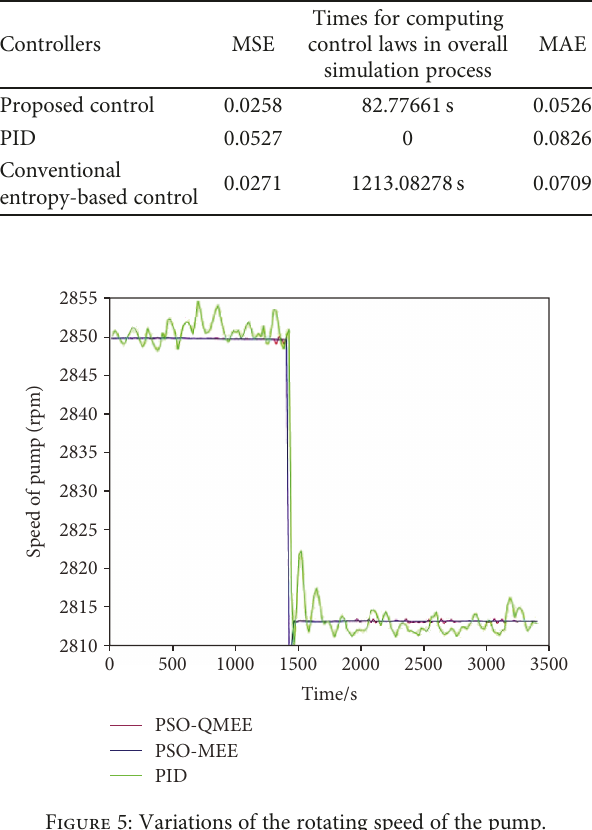
Figure 5: Variations of the rotating speed of the